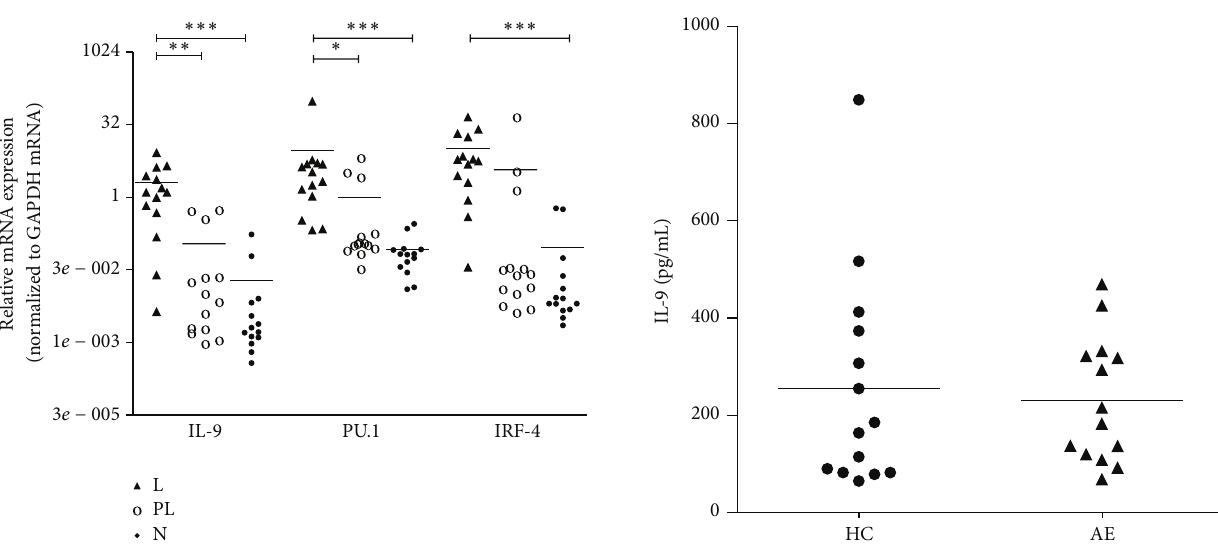
Figure 2: The expression levels of cytokine and transcription factors in different liver tissues. L: lesion group; PL: paralesion group; N: normal liver tissues. 𝑃 value < 0.001 with marker ∗∗∗ ; 𝑃 value 0.001 to 0.01 with marker ∗∗ ; 𝑃 value 0.01 to 0.05 with marker ∗ .